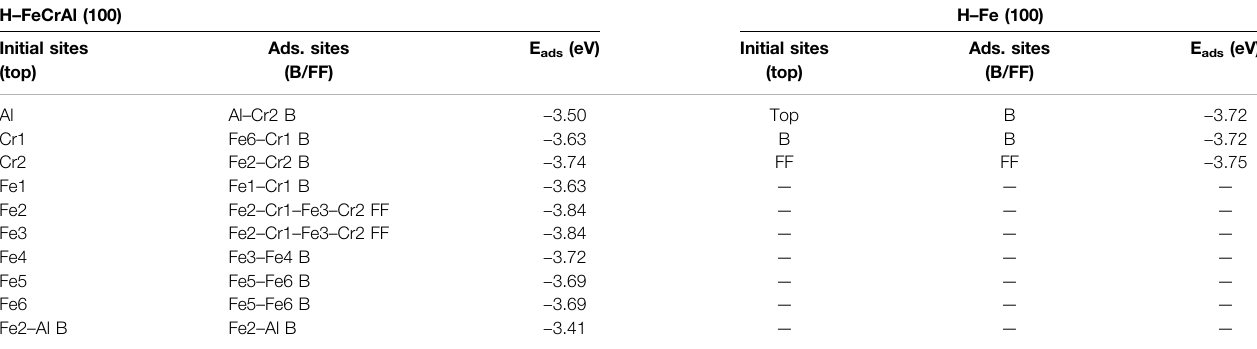
TABLE 1 | Adsorption energies of the H atom on the Fe (100) and FeCrAl (100) surface. H – FeCrAl (100) H – Fe